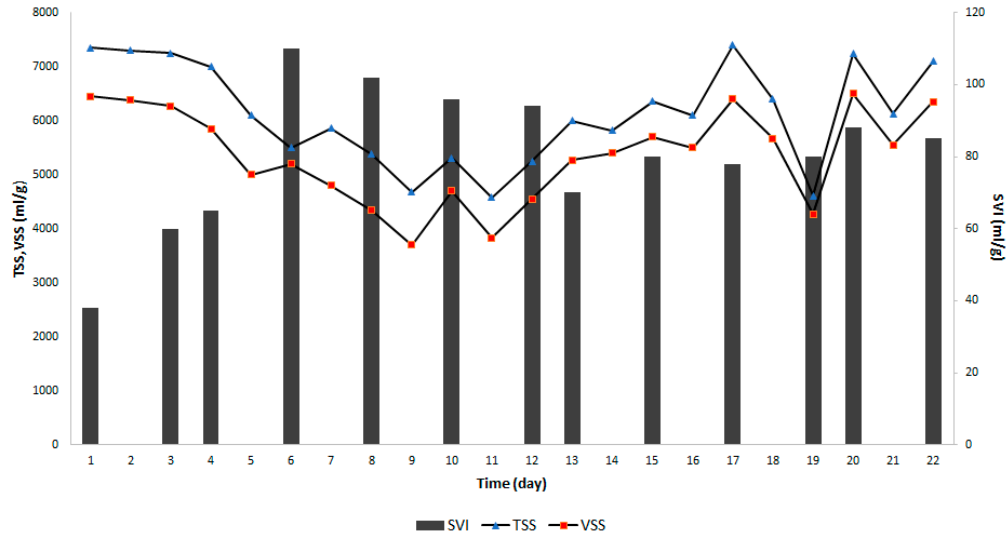
Figure 6. Graphic of the evolution of mass and